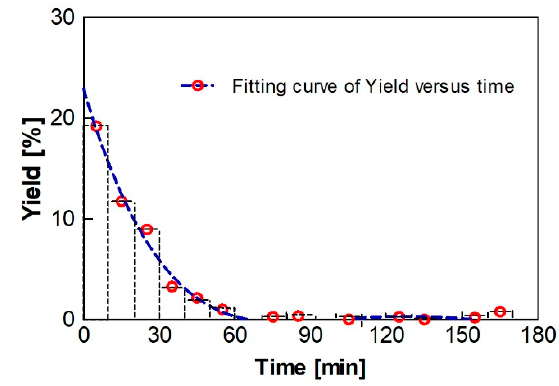
Figure 13. Coating solution yield versus process time .